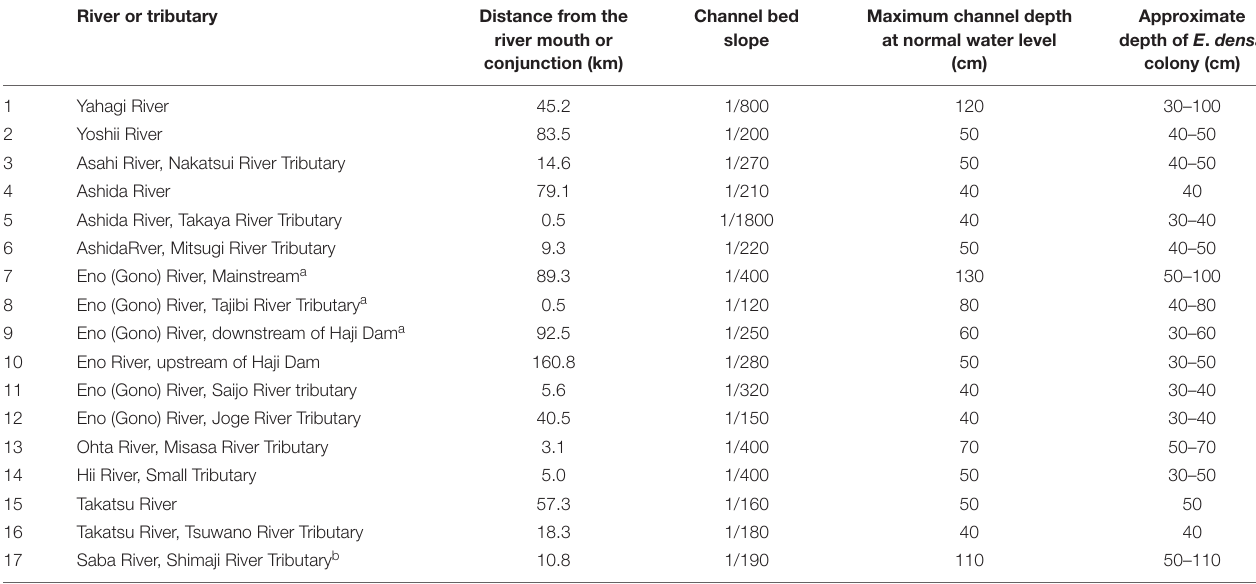
TABLE 1 | River channel data where large colonies of E . densa were found. River or tributary Distance from the